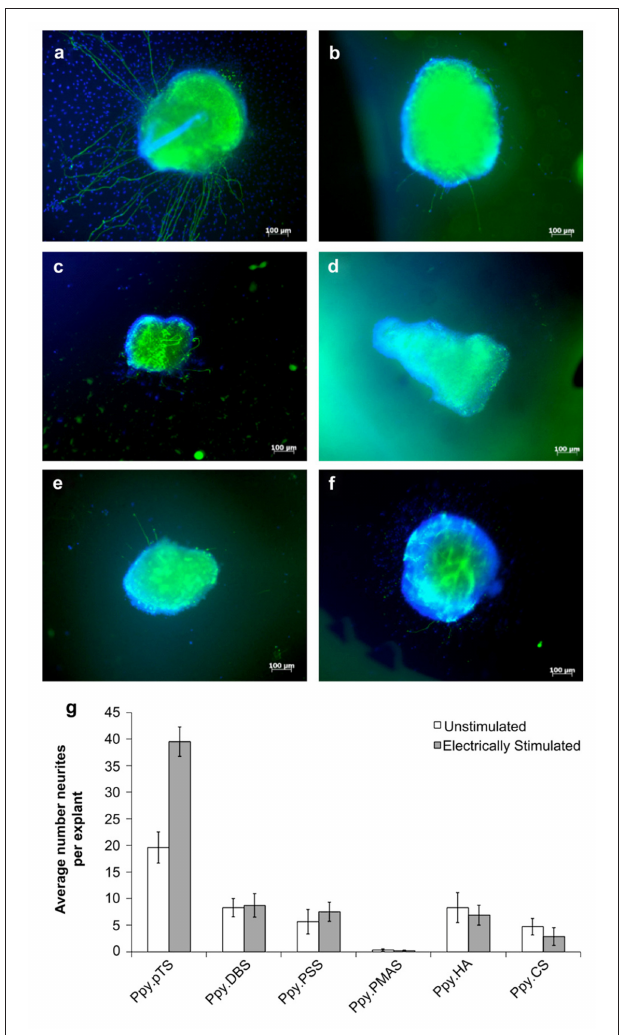
FIGURE 3 | Response of auditory nerve tissue to electrically-controlled NT-3 release from PPy films grown with different dopants. All polymers were grown with 2 mg/mL NT-3 in the polymerisation solution, and 7.2C of charge were passed in the polymerisation of all films. (a–f) Show representative images of explants growing on various PPy films after electrically stimulated release of NT-3 from the PPy. (a) Explants on PPy/pTS, (b) PPy/DBS, (c) PPy/PSS, (d) PPy/PMAS (e) PPy/HA and (f) PPy/CS. (g) The average number of neurites extending from explants grown on electrically-stimulated and unstimulated films over six experiments. The error bars show one standard error of the mean of 6–60 explants on each polymer. Reproduced with permission from Thompson et al.